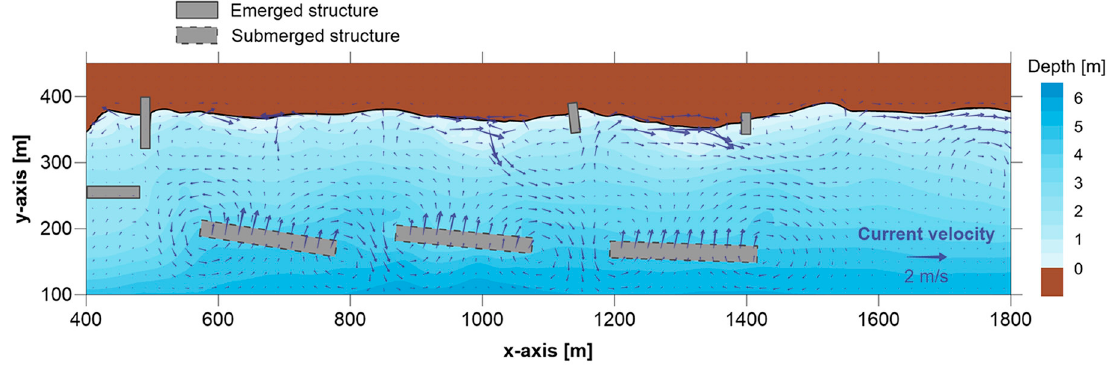
Figure 5. Breaking wave-induced current field for the prevailing SE waves at Paralia Katerinis beach (Greece) after the construction of the detached submerged breakwaters.